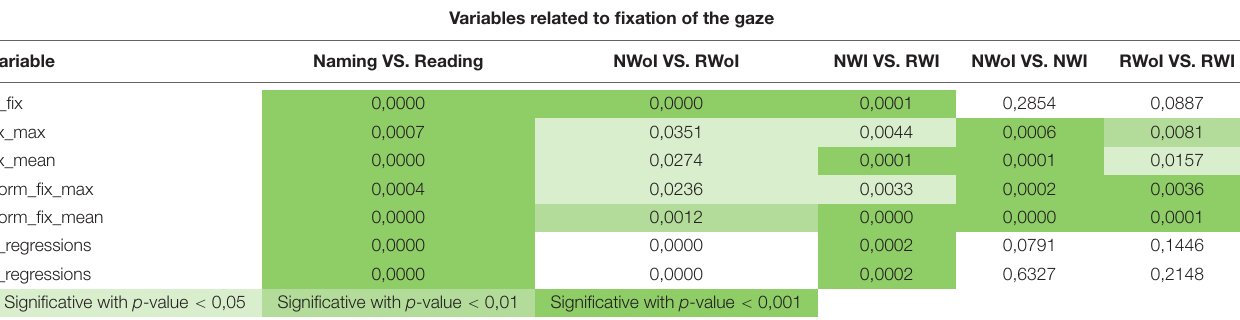
TABLE 1 | P -values generated by the one-way ANOVA on fixations variables when comparing three pairs of tasks: NWoI vs. RWoI, NWI vs. NWoI, and RWI vs. RWoI. Variables related to fixation of the gaze Variable Naming VS.